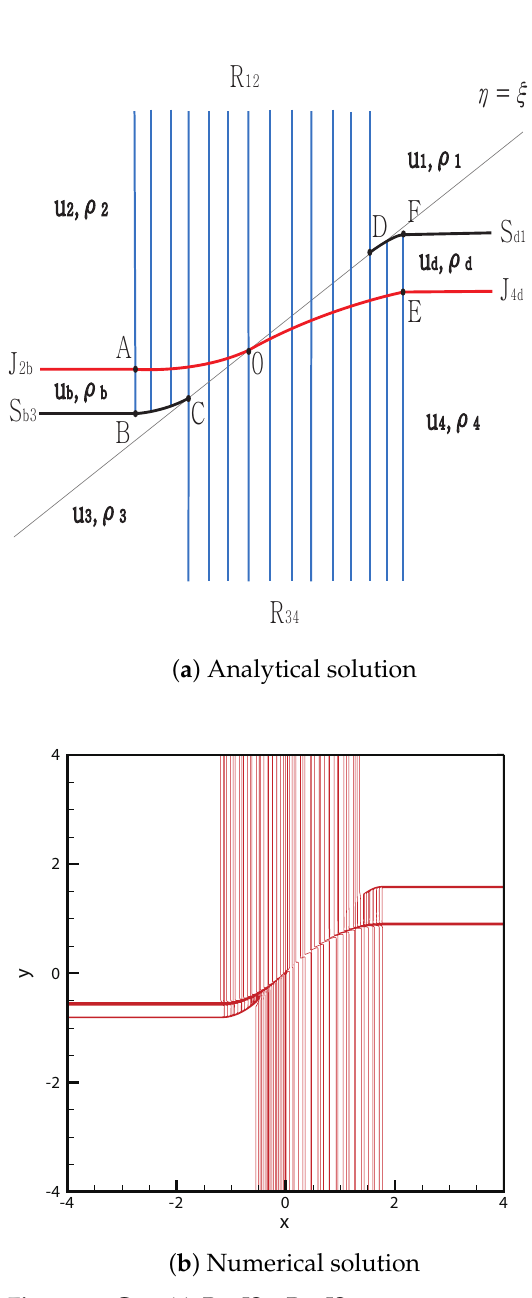
Figure 16. Case 14. R + JS + R +